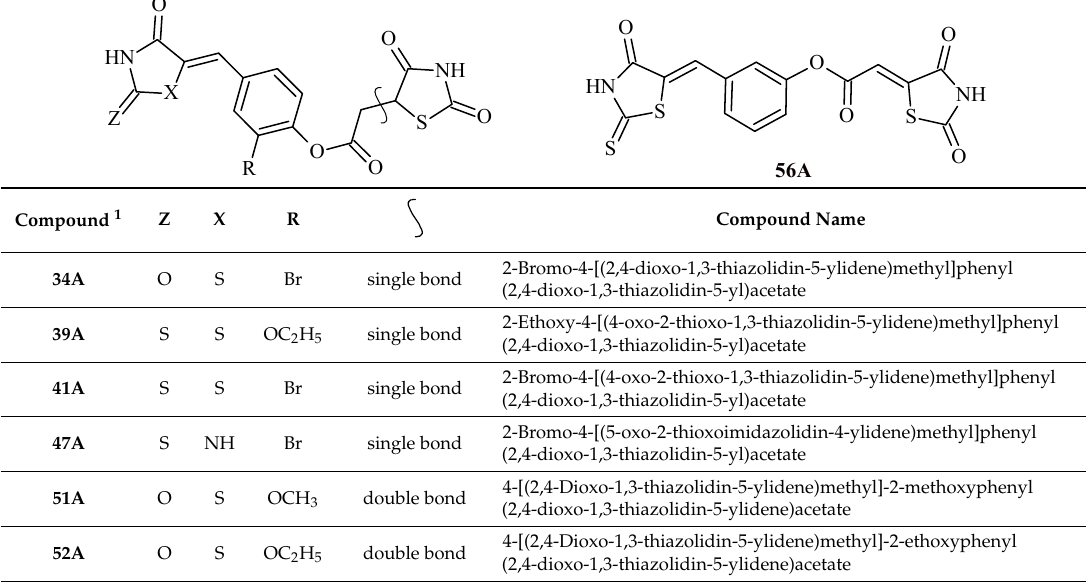
Table 1. Thiazolidine-2,4-dionebased azolidine hybrids (series A) symbols and structure. Table 2. TZD ‐ based chlorophenylthiosemicarbazone hybrids (series B) symbols and structure.